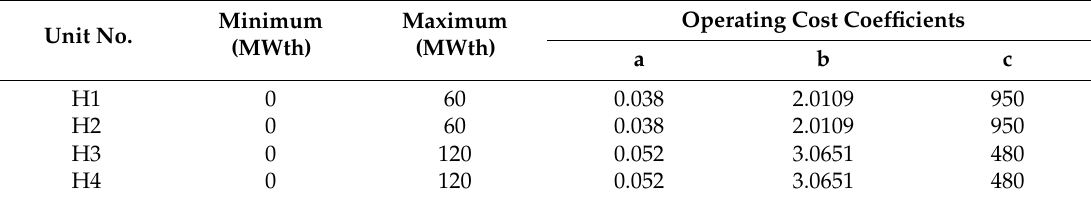
Table 4. Parameters of heat-only